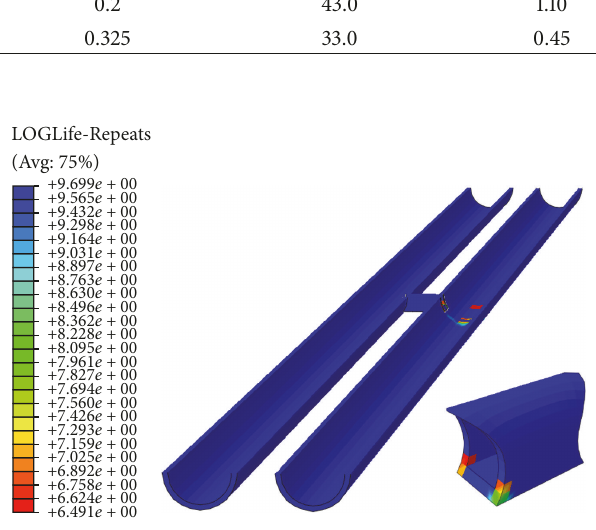
Figure 8: Distribution nephogram of fatigue life of cross tunnel structure.